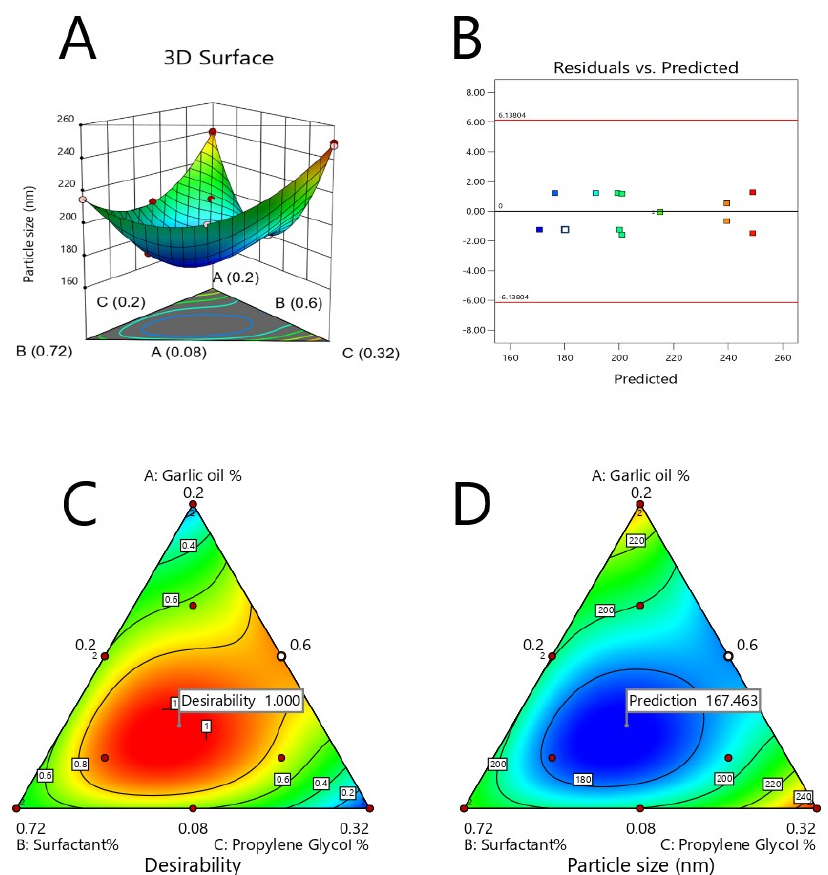
Figure 3. Graphical representation of the effects of independent variables on particle size of ACV-GO SNEDDS: ( A ) 3D-response surface plots, ( B ) Residual versus predicted plot, ( C ) contour plot showing effect of ACV-GO SNEDDS content on the desirability ( D ) contour plot showing effect of ACV-GO SNEDDS content on the response parameter.